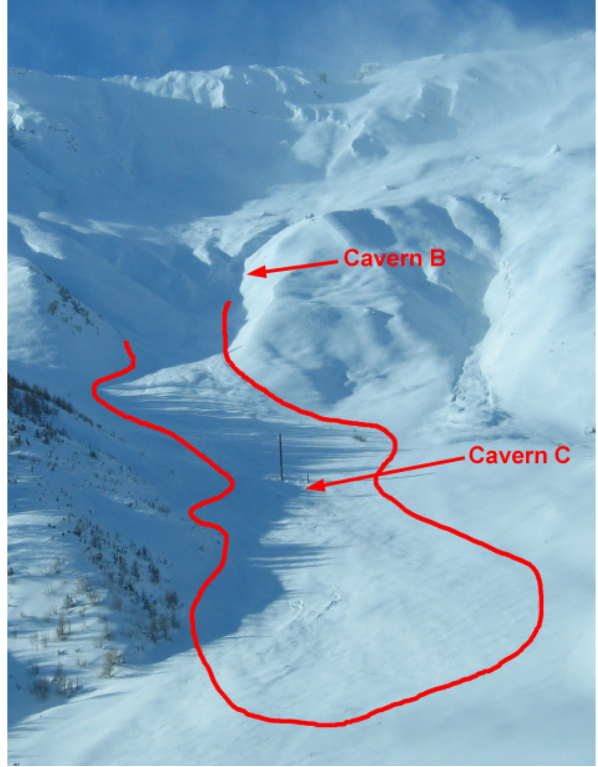
Fig. 10. Avalanche 3 viewed from the shelter. Avalanche 3 oc- curred on 11 February 2009 at 01:30 (photo source: F. Dufour). The avalanche deposit is outlined in red. The 20m measurement pylon is visible above the red arrow indicating the location of cavern C. Deposit boundaries are difficult to identify.